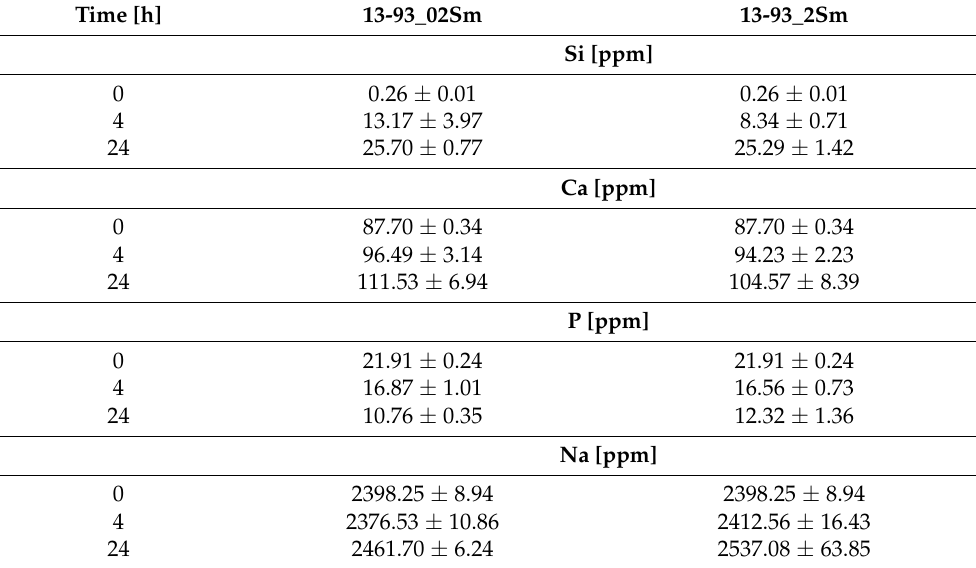
Table 2. Ion concentration of SBF containing 13-93 doped with 0.2 and 2 %mol Sm 2 O 3 under initial conditions, after 4 and 24